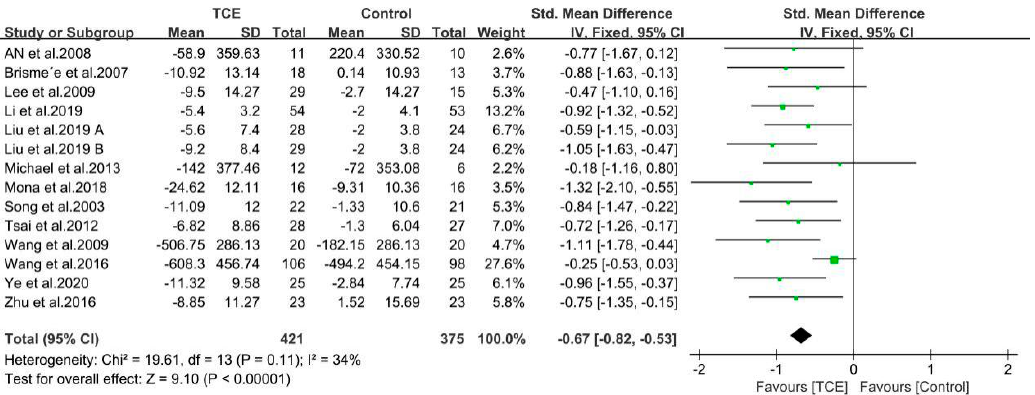
McMaster Universities Arthritis Index.